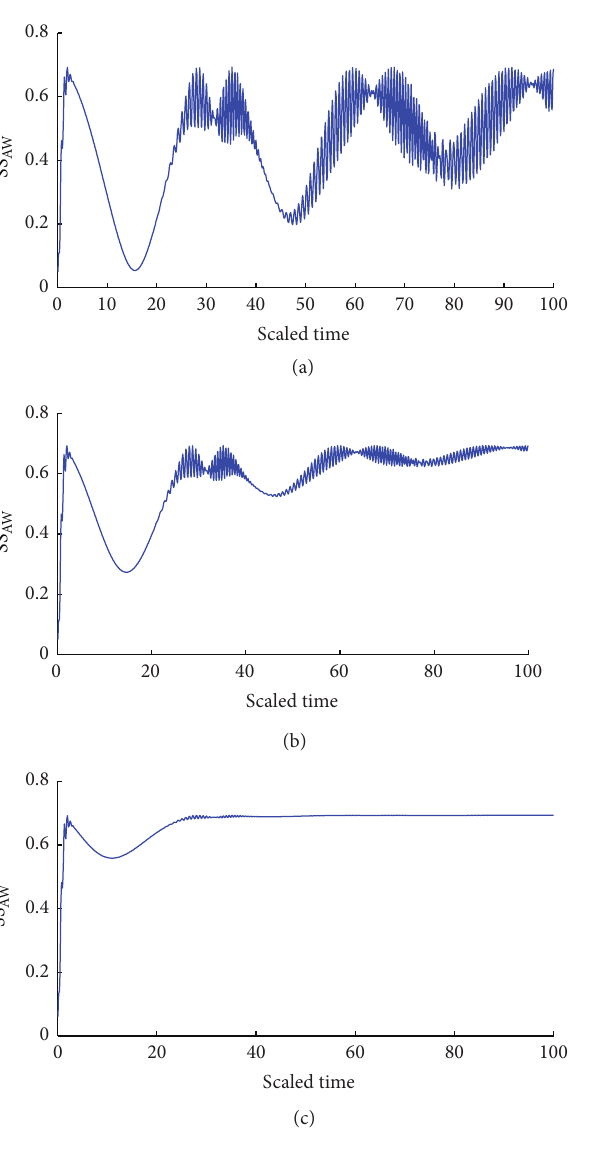
(𝑡) as a function of the dimensionless time 𝜆𝑡 for 𝛼 = 5 and with different Figure 2: The evolution of the scaled atomic Wehrl entropy SS AW values of the atomic damping parameter 𝛾/𝜆 and number of photon transition 𝑘 where ((a), (b), (c)) 𝛾/𝜆 = (0.0001, 0.05, 0.1) and ((d), (e), (f)) are the same as ((a), (b), (c)) but 𝑘 = 2